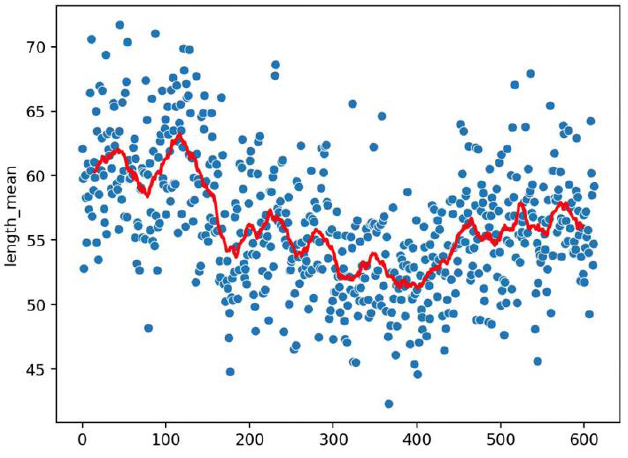
Figure 5. Dot representation of Figure 4. As for Figure 3 we can detect eventual anomalies during the acquisition (e.g., out of focus).